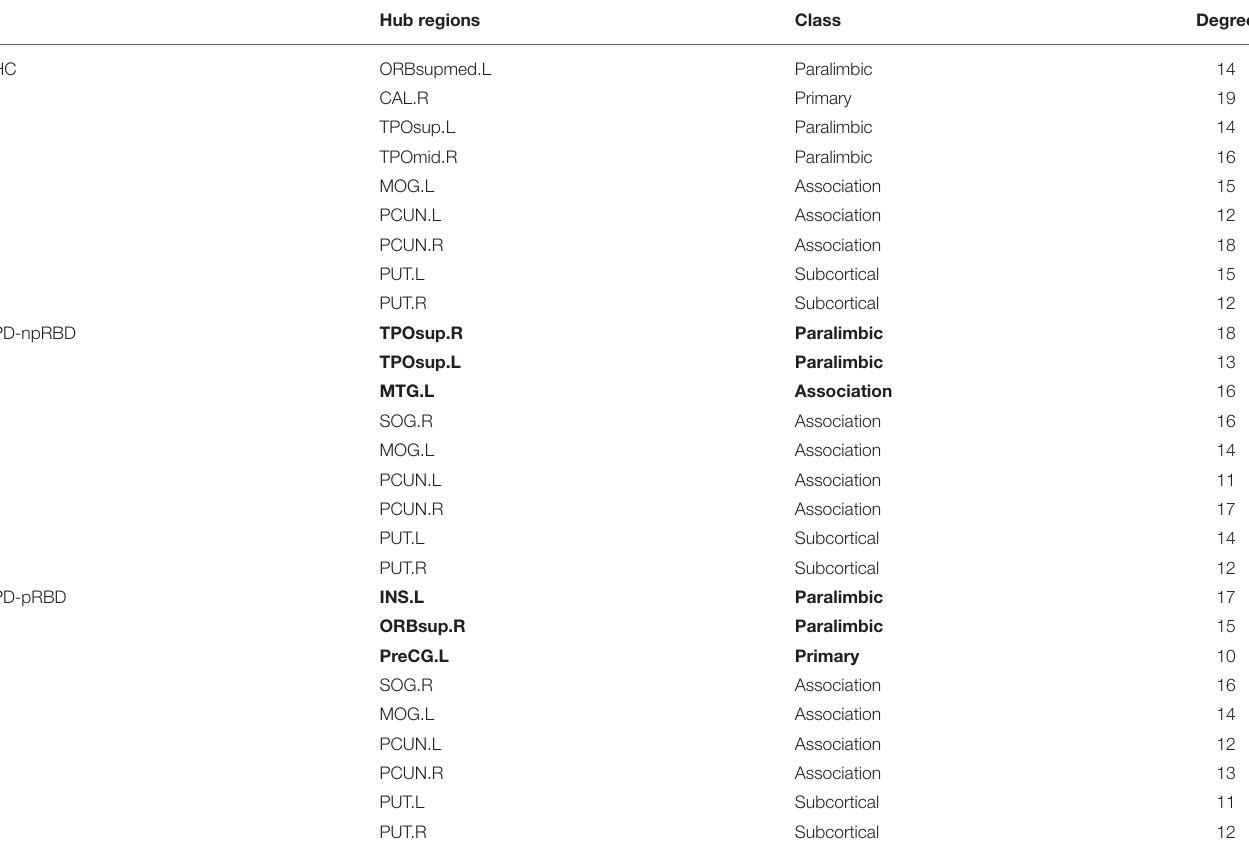
TABLE 3 | Hubs characteristic of the HC, PD-npRBD, and PD-pRBD groups.